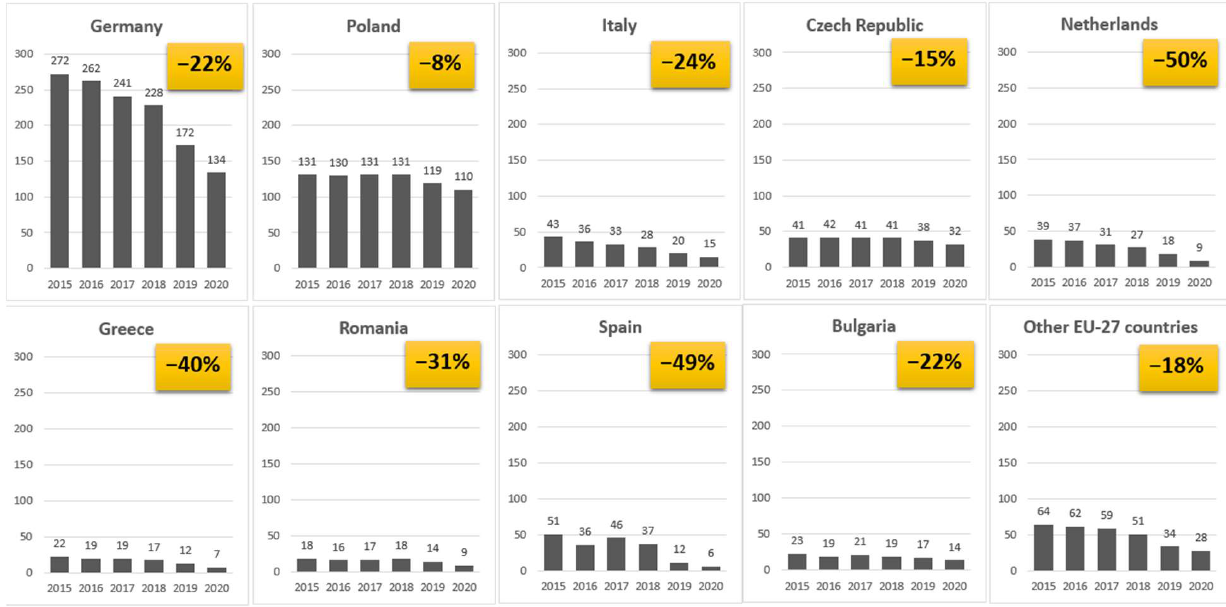
Figure 2. Hard coal and lignite generation, percentage change from 2019 to 2020, source: own study based on [9].